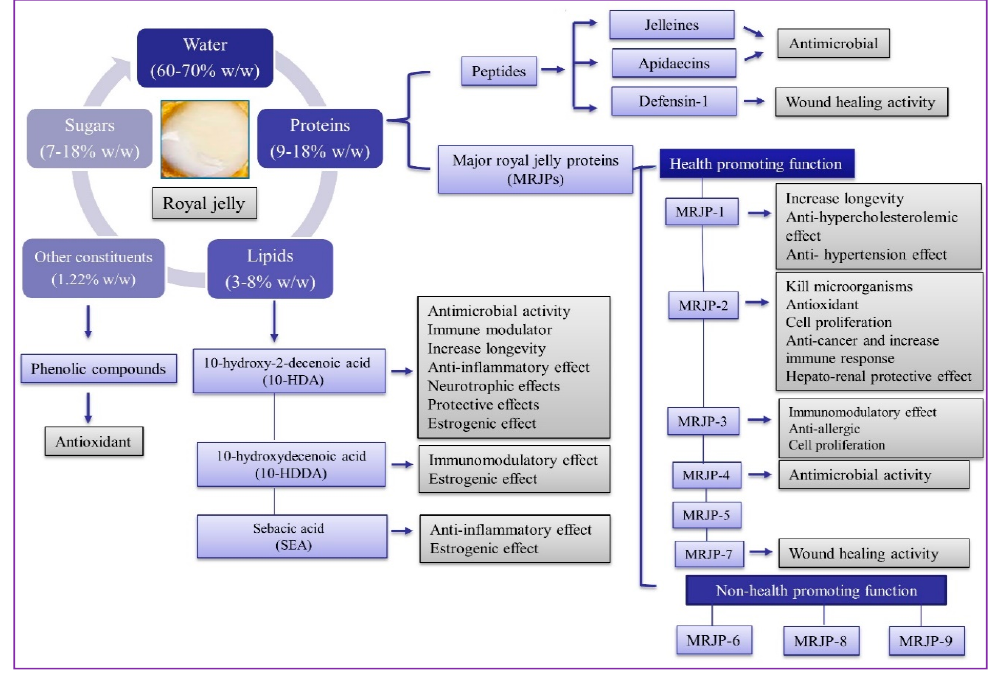
Figure 3. A schematic representation of the main biological substances in RJ and their functional activities. For detailed information refer to Table 1. activities. For detailed information refer to Table